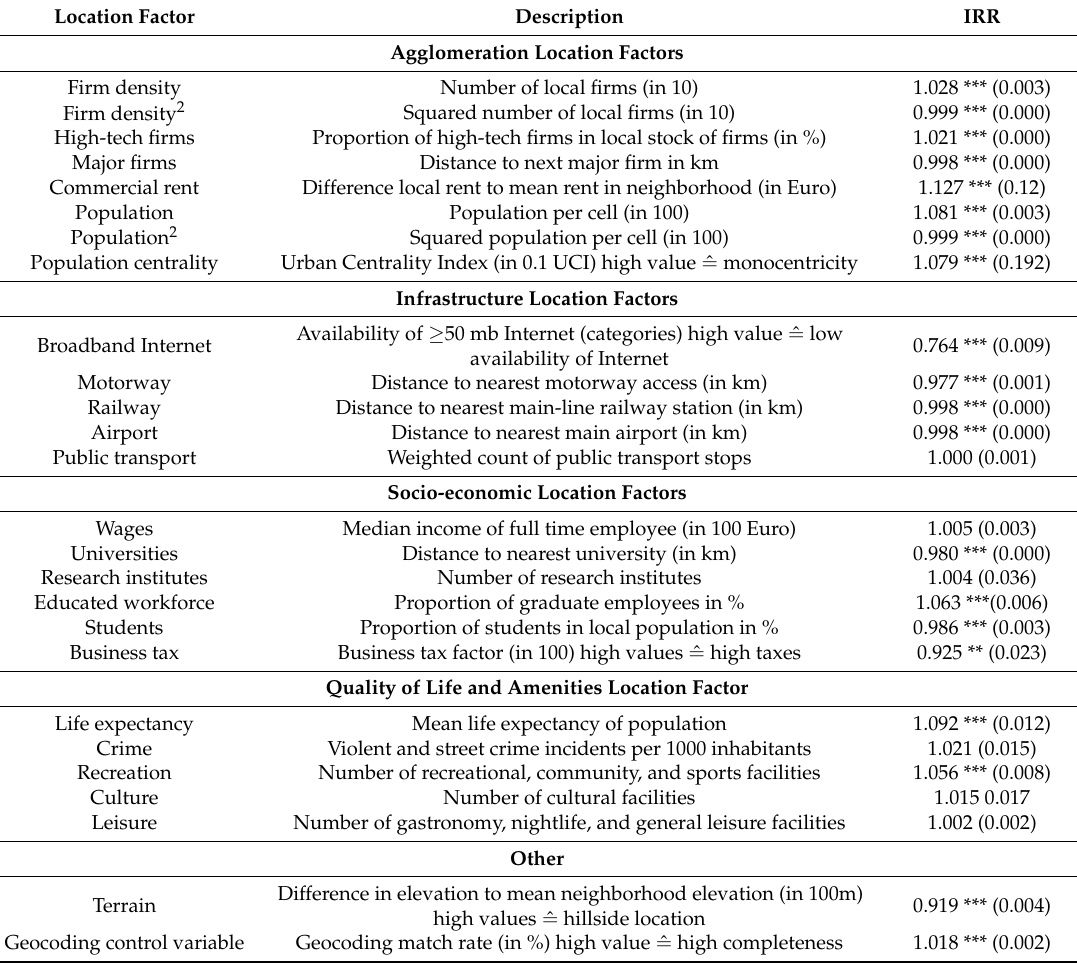
Table 2. Location factors and estimated coefficients with robust standard errors in